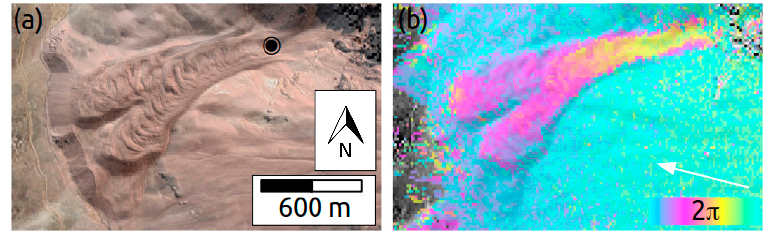
Figure 10. ( a ) Dos Lenguas rock glacier (Argentinian Andes) with position of the Sentinel-1 InSAR time series of Figure 11 (black dot), image data are from Google, DigitalGlobe; ( b ) Sentinel-1 interferogram from 21.04.2017 to 27.04.2017, 2 π ⇔ 2.8 cm. The white arrow indicates the satellite line-of-sight.